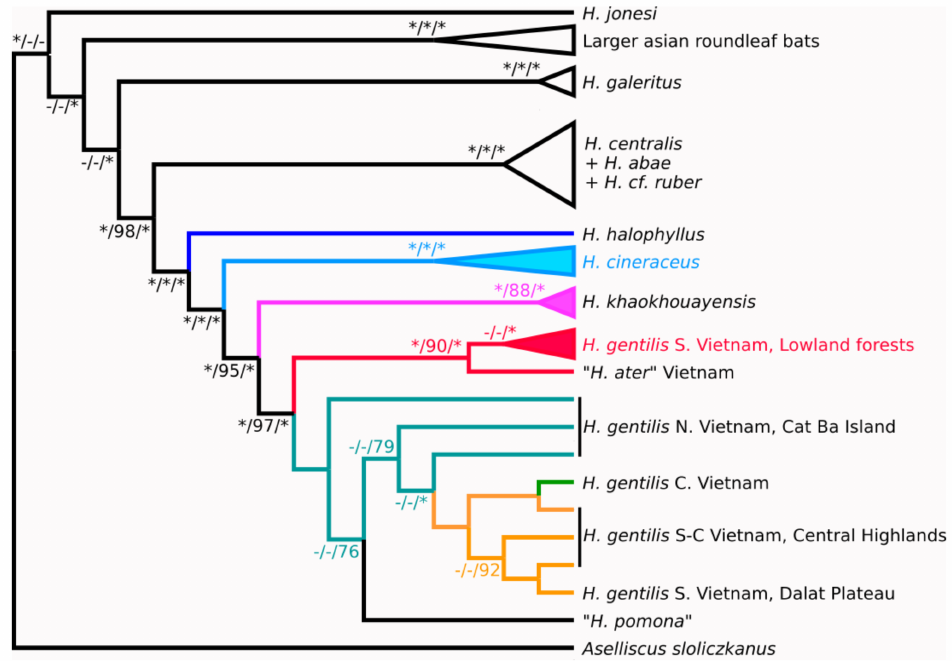
Figure 3. Phylogenetic tree based on seven nuclear gene topologies combined by MRP method. Bayesian/maximum likelihood/MRP supports are shown at the tree nodes. Maximum supports are denoted with asterisks. Dash symbols denote nodes, which didn’t appear on respective